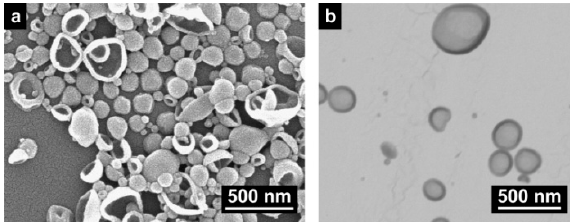
Figure 2. The morphology of PU NCs prepared using 1 wt% of ABIL EM 90 as the surfactant: ( a ) SEM and ( b ) STEM images.